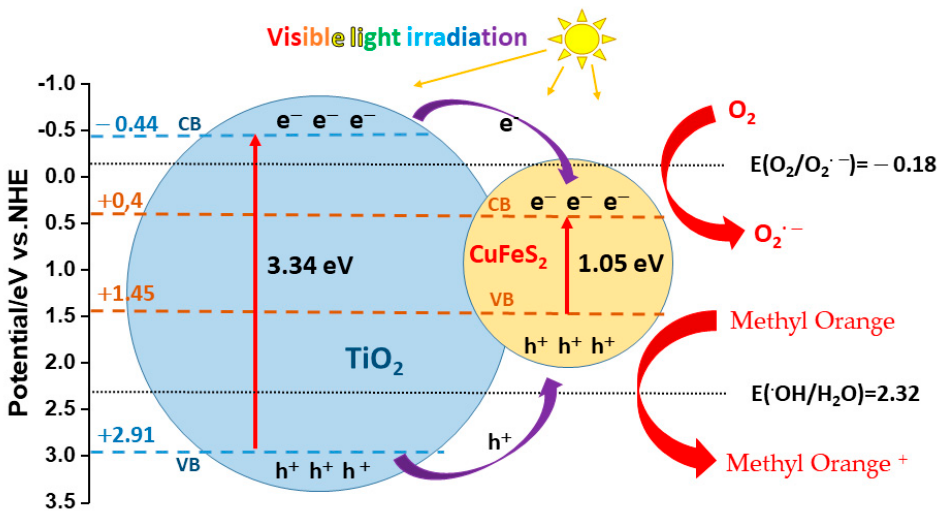
Figure 11. Schematic illustration of delocalization of charge carriers and the formation of reactive regions on the catalyst surface under visible light illumination.